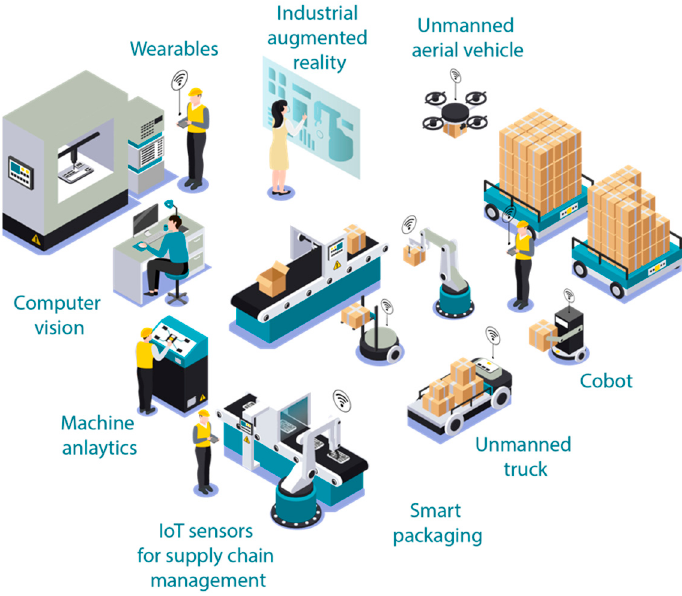
Figure 1. Concept of a smart factory.